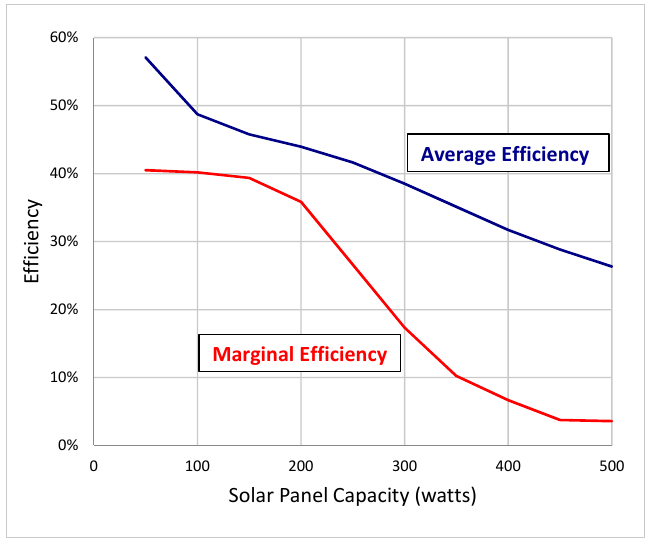
Figure 2. Both marginal and average cooking system efficiency for a 4-liter cooker analyzed in this study where water is drawn from the cooker two times per day. study where water is drawn from the cooker two times per